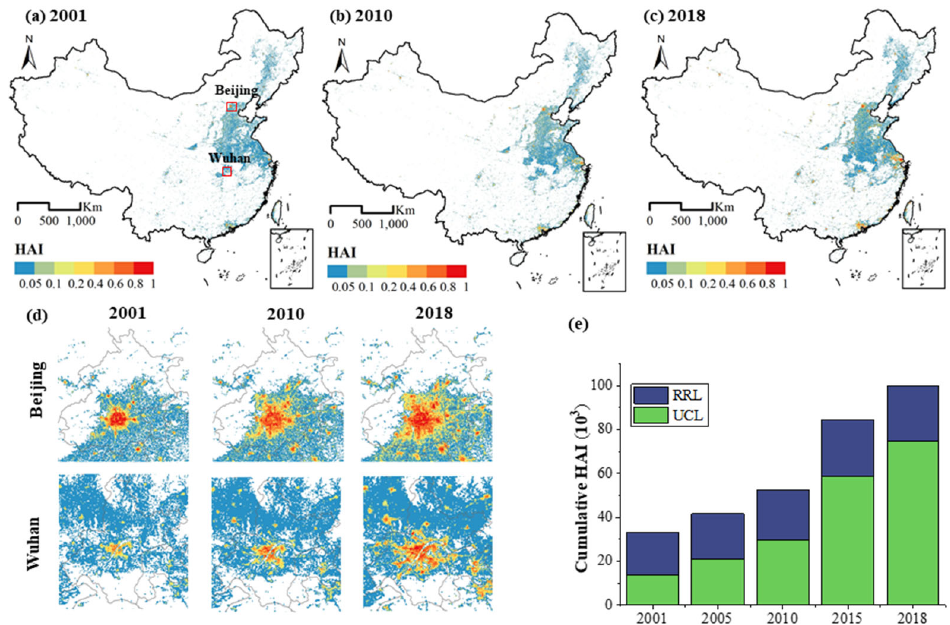
Figure 4. Human activity intensity of China from 2001 to 2018.